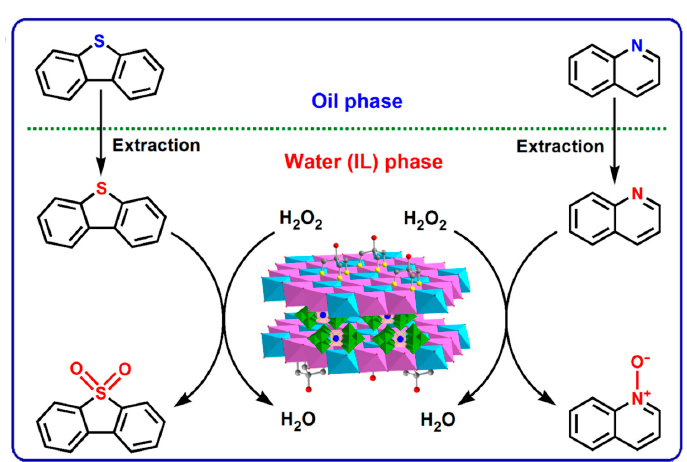
Figure 8. Proposed schematic of extraction and catalytic desulfurization and denitrogenation route with H 2 O 2 /[bmim]BF 4 /TrisLDH ‐ LaW 10 . Adapted from Ref. [53], Copyright 2016, Royal Society of Chemistry.